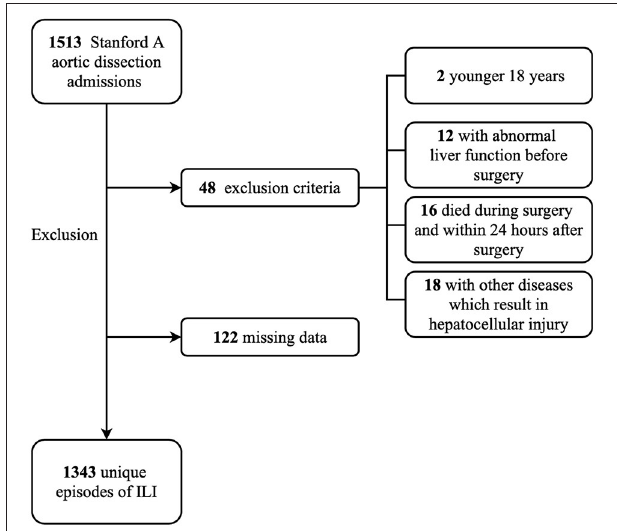
FIGURE 1 | Flow diagram of the exclusion criteria. ILI, ischemic liver injury.